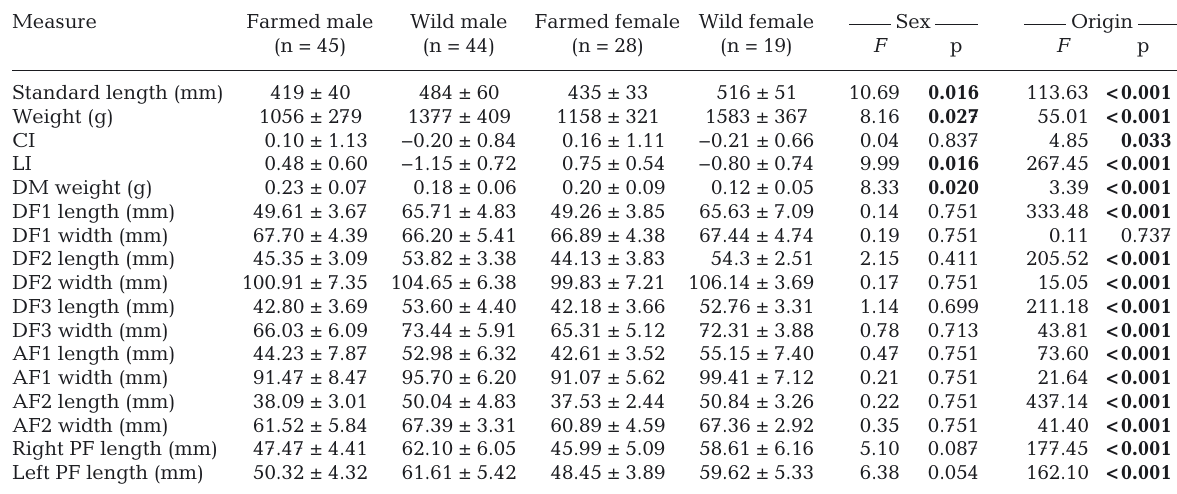
Table 1. Mean (±SD) morphometric measures and analyses by sex and farmed or wild origin Atlantic cod Gadus morhua . Stan- dard length and weight measures are unstandardized; the calculation of condition index (CI) and liver index (LI) includes an in- herent standardization. Drumming muscle weight has been standardized to a common weight, while all other measures have been standardized to a common centroid size. DM: combined dried mass of right and left drumming muscles; DF1, DF2, DF3: first through third dorsal fins; AF1 and AF2: first and second anal fins; PF: pelvic fins. There were no significant interactions between sex and origin for any of the measures. Adjusted p-values are shown, and those significant are in bold ( α =